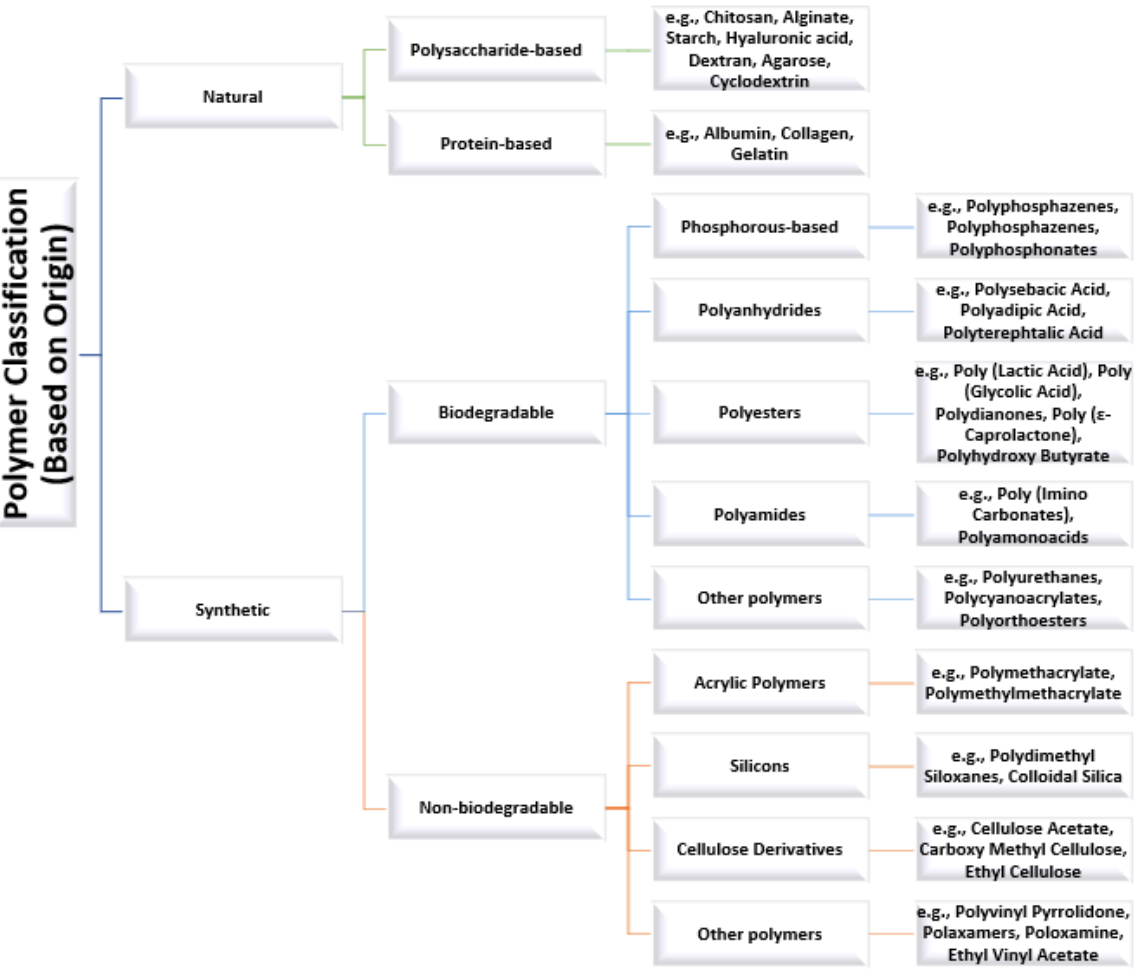
Figure 1. Polymer classification. Created based on information from literature references [11,21,22].